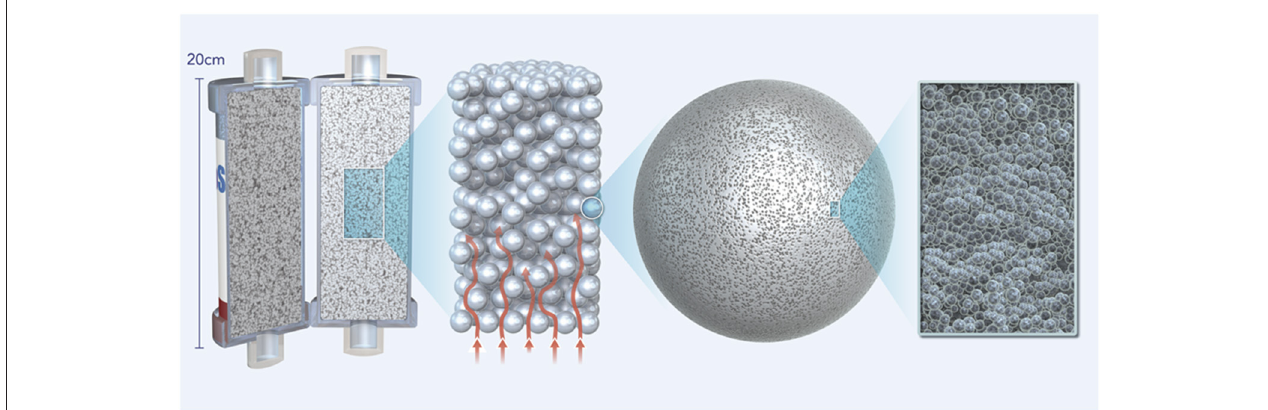
FIGURE 1 | Figure showing the active matrix of the CytoSorb adsorber consisting of highly biocompatible porous polystyrene divinylbenzene (PSDVB) copolymer beads covered in a biocompatible polyvinylpyrrolidone